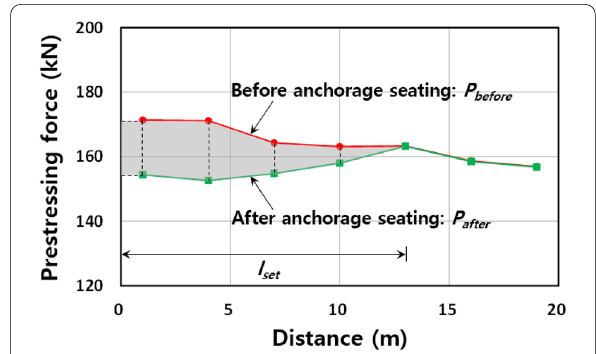
Fig. 11 Example of the shaded region used to calculate draw‑in slip (T1–H7 of full‑scale specimen).